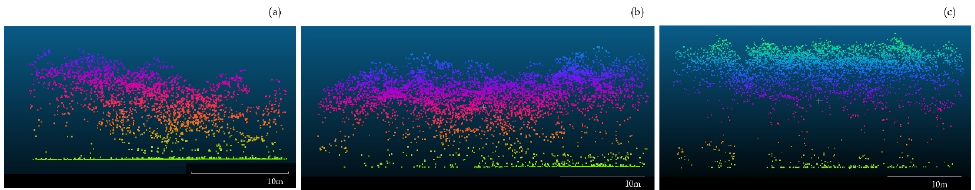
Figure 5. Lidar Cloud point data for ( a ) Plot 25 (field AGB_ssp: 45.56 t · ha − 1 ); ( b ) Plot 09 (field AGB_ssp: 126.37 t·ha −1 ); and ( c ) Plot 20 (field AGB_ssp: 186.10 t·ha −1 ).